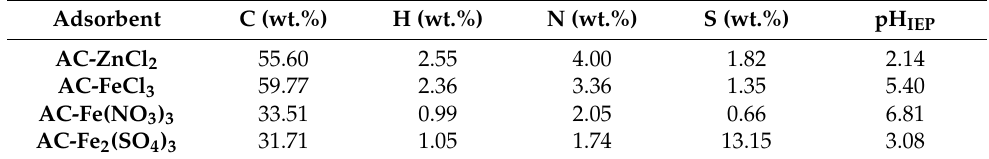
Table 3. Elemental analysis results and isoelectric point (pH IEP ) values of the carbon materials. Adsorbent C